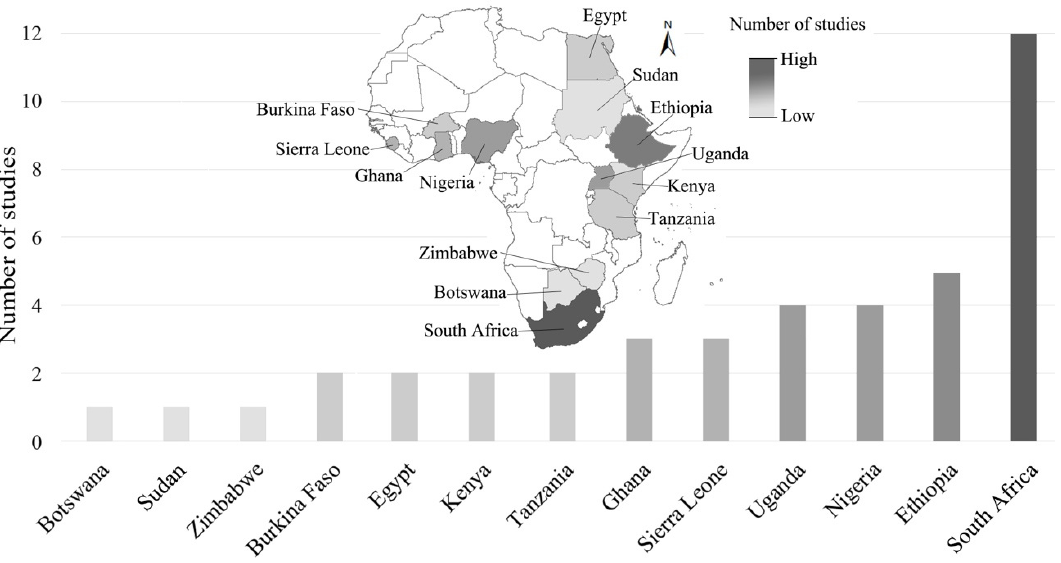
Figure 4. Distribution map of cities identified in the literature review.